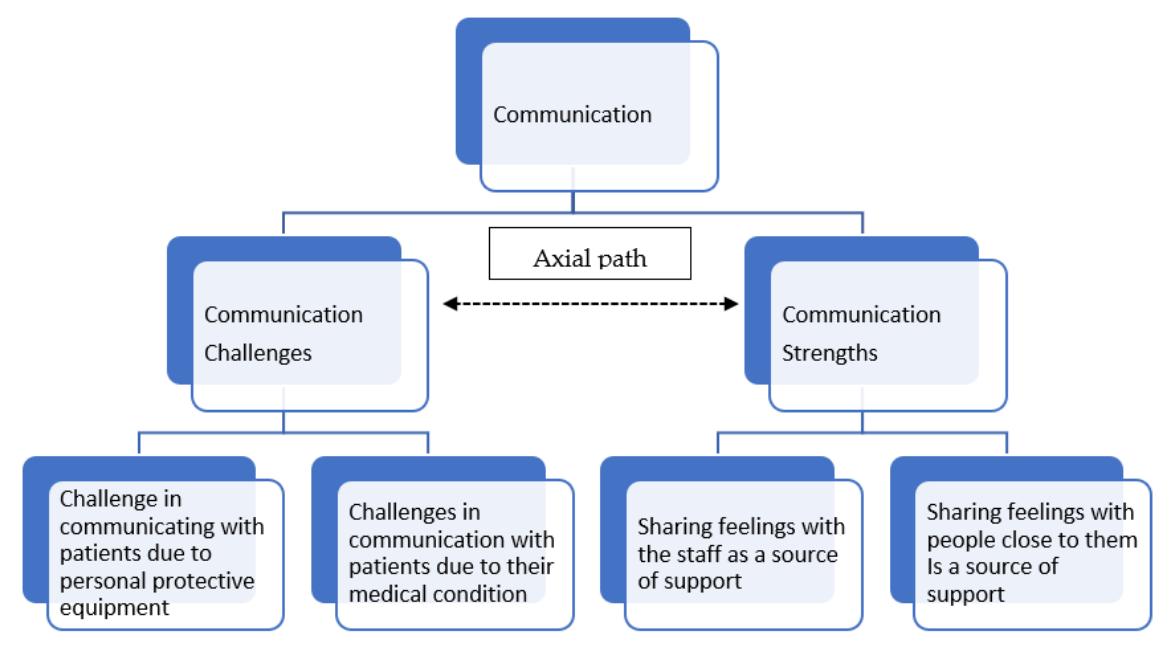
Figure 1. Hierarchy of themes.